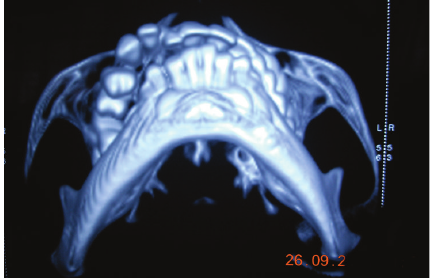
Figure 4: Submandibular view in CT scan showing the right side osseous maxillary alveolar